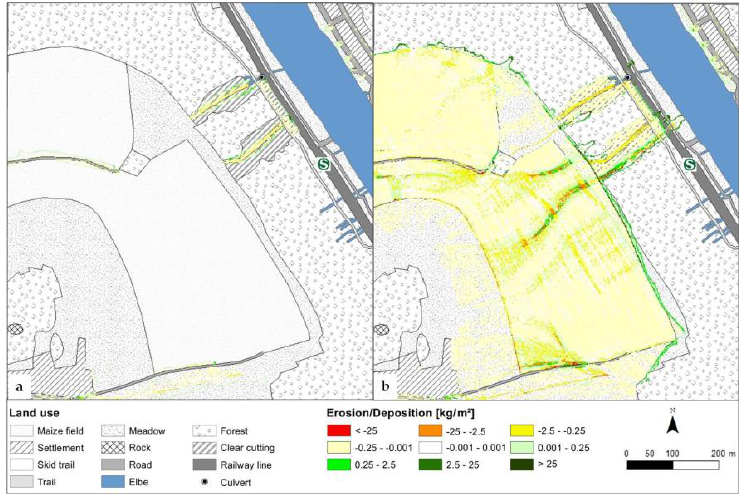
Figure 11. The erosion risk map with ( a ) RY- and ( b ) RZ-product for 23 May 2016.